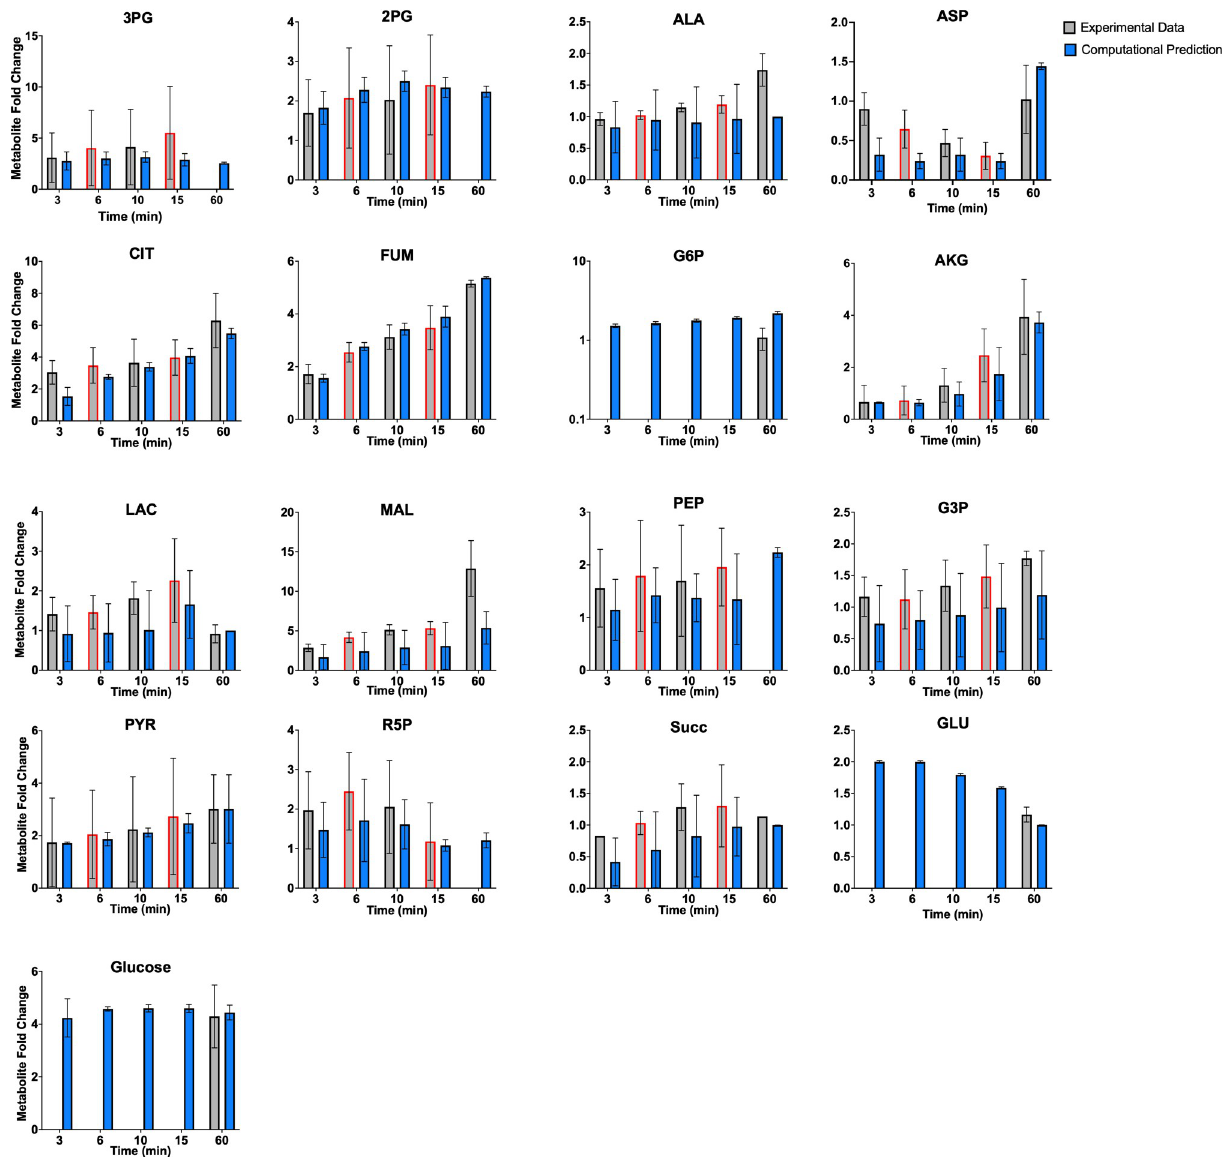
Fig 2. Model fit to relative 16.7/2.8mM glucose experimental data. We trained the model to mass spectrometry data published by Spegel et al. and Malmgren et al., for the 3-, 10-, and 60-minute time points (gray bars with black outline) for 17 distinct metabolites [51, 52]. Model predictions (blue bars) match experimental measurements; the error bars represent the standard deviation of model predictions across the eight best-fit parameter sets. The experimental data for the 6- and 15-minute time points (gray bars with red outline) were withheld as validation data to test the robustness of model predictions. Predicted fold-changes for metabolites found in both the cytosol and mitochondria are summed together as a total metabolite pool, in order to compare to the experimental data. algorithm to complete this analysis [66]. The input matrix was 5 rows by 65 columns, with the columns representing the predicted average flux for each model reaction, and the rows repre- senting the five time points of interest. The output matrix was 5 rows by 1 column, corre- sponding to experimentally measured insulin secretion fold-change at the five time points. By performing partial least squares regression, we specify the relationship between flow of mate- rial through the metabolic network and insulin released by the β -cell. The 6- and 10-minute